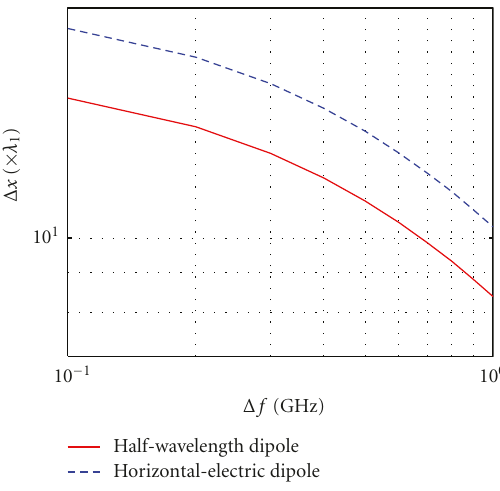
Figure 7: Coherence time , with respect to the value of the MS speed | v | , considering two di ff erent EASs: EAS I ( α = 10) and EAS II ( α = 1), Laplacian AAS pdf ( a = 0 . 25 rad), using exponential DP with τ = 3 . 33 microseconds, σ = 1microseconds, f 1 = f 2 = 1 GHz, and for a SISO communication system; employing half-wavelength antenna or horizontal-electric antenna.